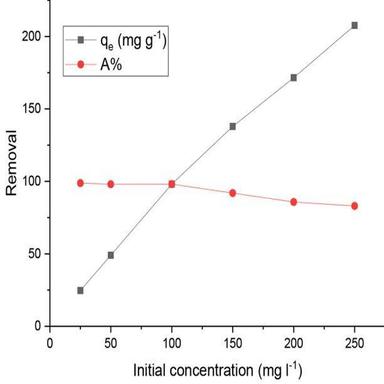
The influence of initial dye concentration on the adsorption of MB on Perlite@GO.